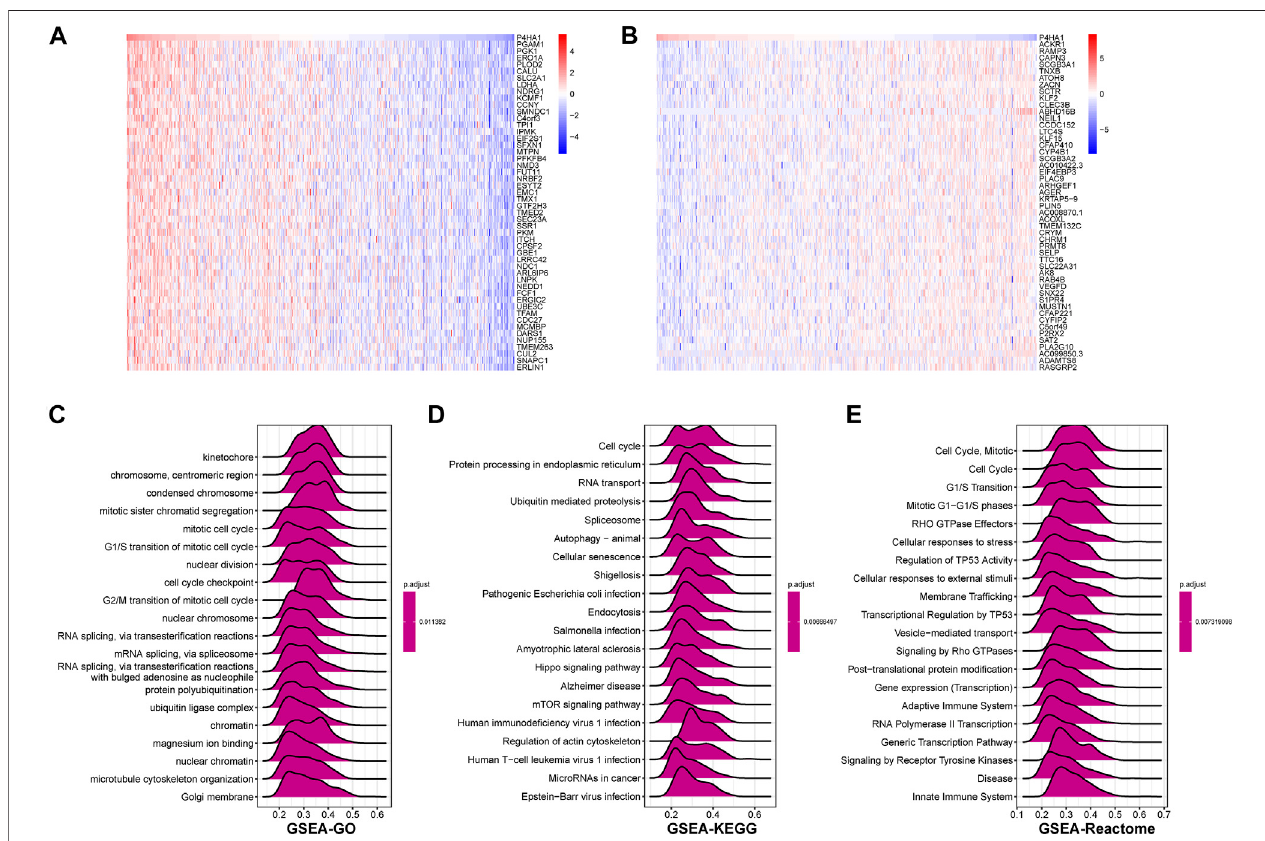
FIGURE 7 | GSEA of P4HA1 in LUAD (A) The heatmap of top 50 genes positively correlated with P4HA1 expression. (B) The heatmap of top 50 genes negatively correlated with P4HA1 expression. (C – E) The top 20 GSEA results based on GO (C) , KEGG (D) , and Reactome (E) database shown in indicated tumor types.